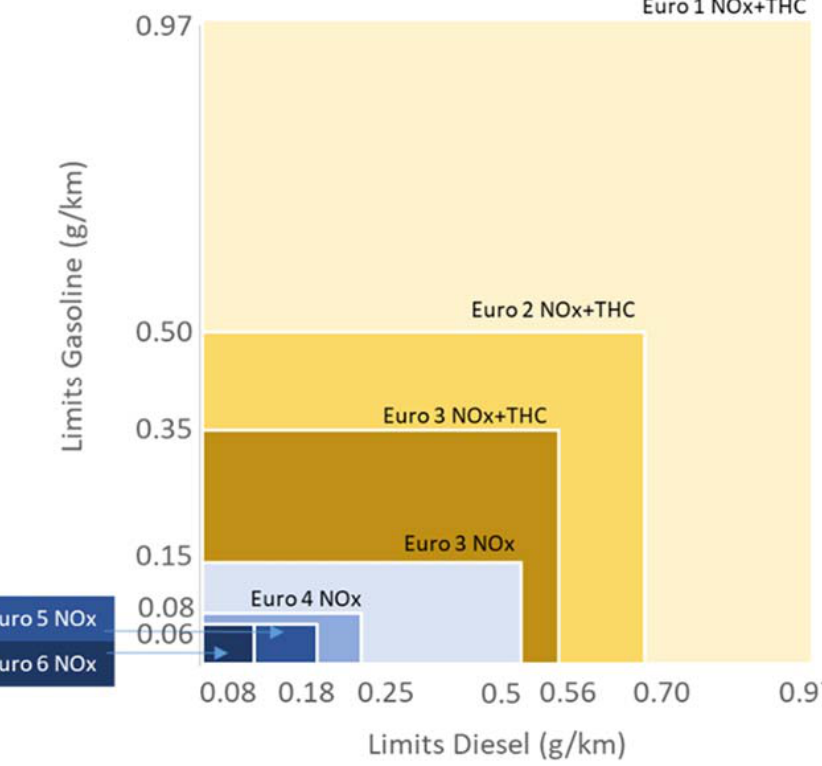
Figure 1. Evolution of NOx emissions limits enforced by EU regulation for gasoline and Diesel light-duty vehicles (LDVs).